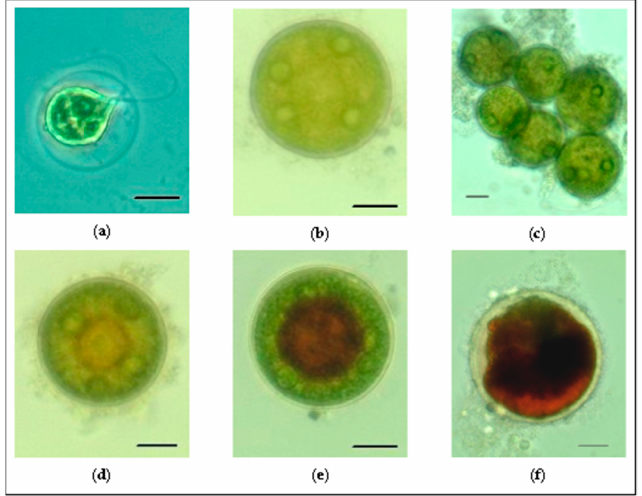
Figure 4. Light micrographs of H. pluvialis cells. ( a ) zoospore, phase contrast; ( b , c ) palmella cells; ( d , e ) intermediate cells, bright field, scale bar = 10 µm; ( f ) mature aplanospores, bright field, scale bar = 20